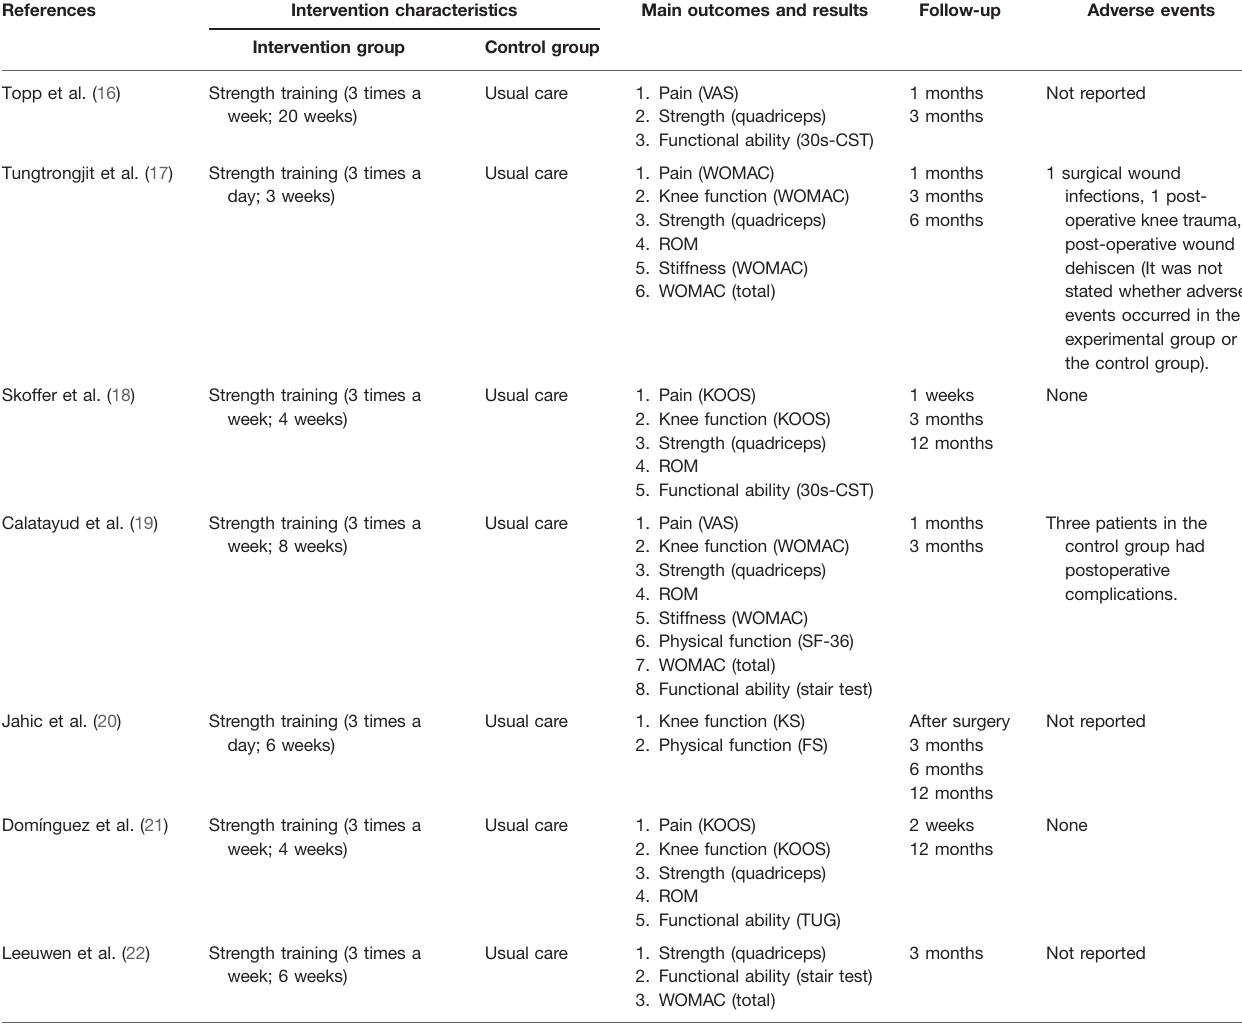
TABLE 2 | Intervention characteristics and outcome